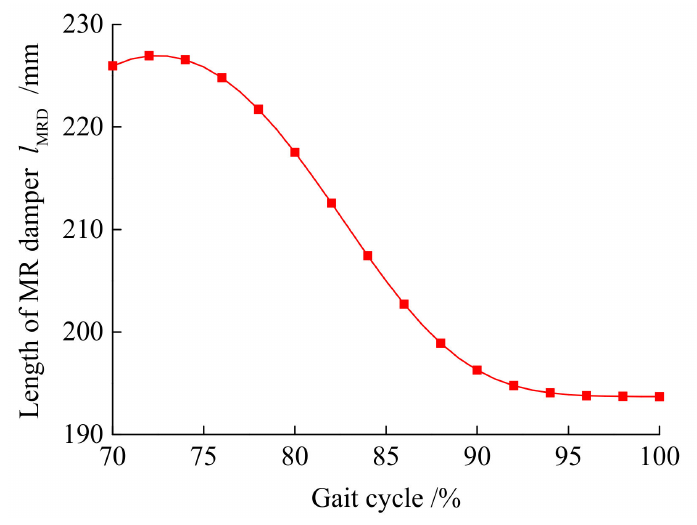
Figure 5. Length of the MR